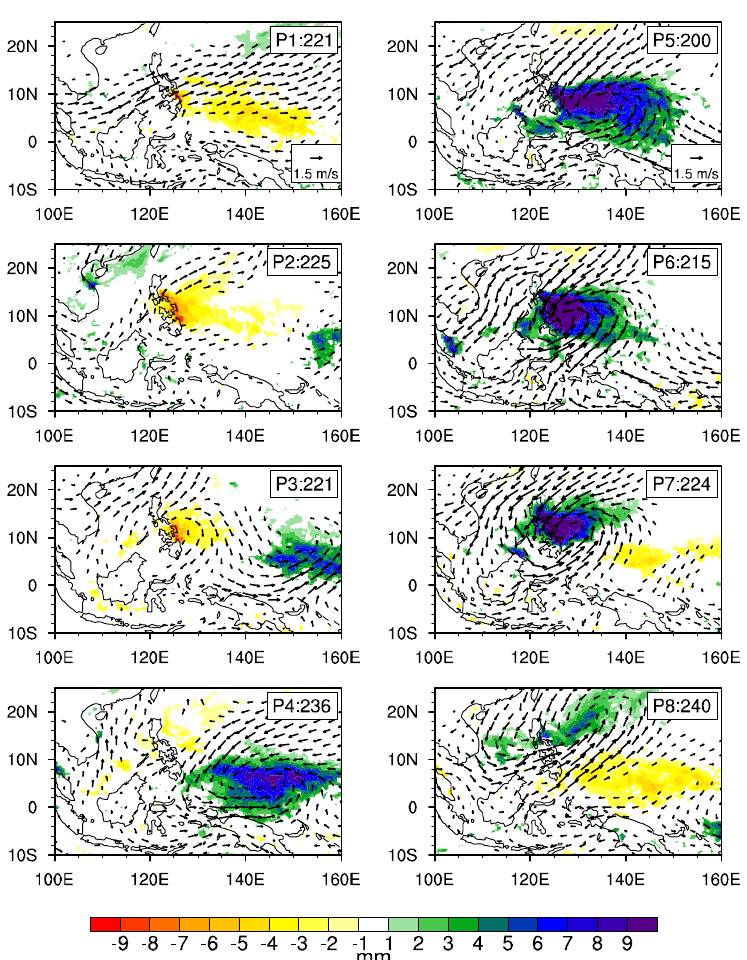
Figure 3. Composite anomalies of precipitation (shade, SI = 1 mm) and 925 hPa winds (vector, unit: 1.5 ms −1 ) during eight phases of the QBWO over the WNP. Number in top-right represents the composite days in each QBWO phase. Values and vectors exceeding the 95% confidence levels based on the two−tailed Student's t −test are shown.